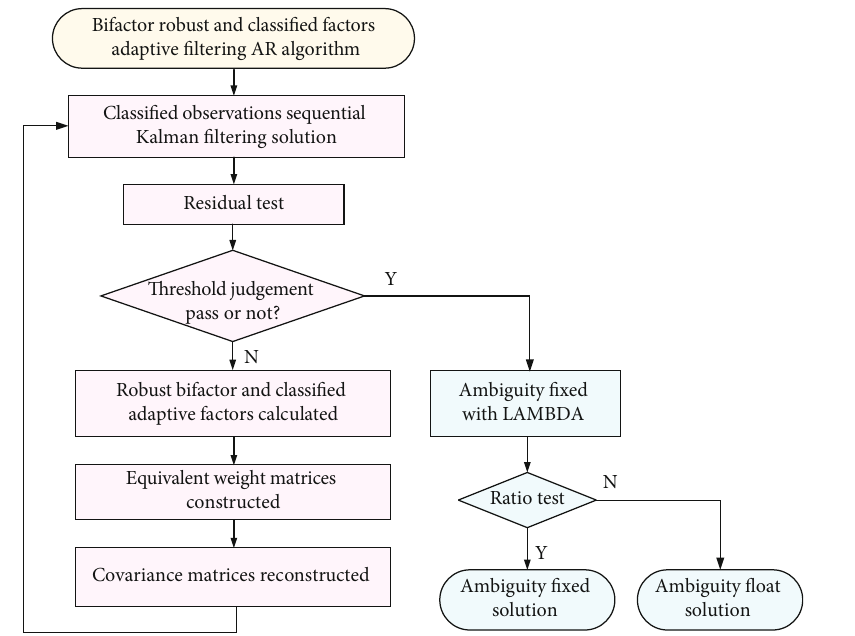
Figure 2: The bifactor robust and classi fi ed factor adaptive fi ltering AR algorithm fl